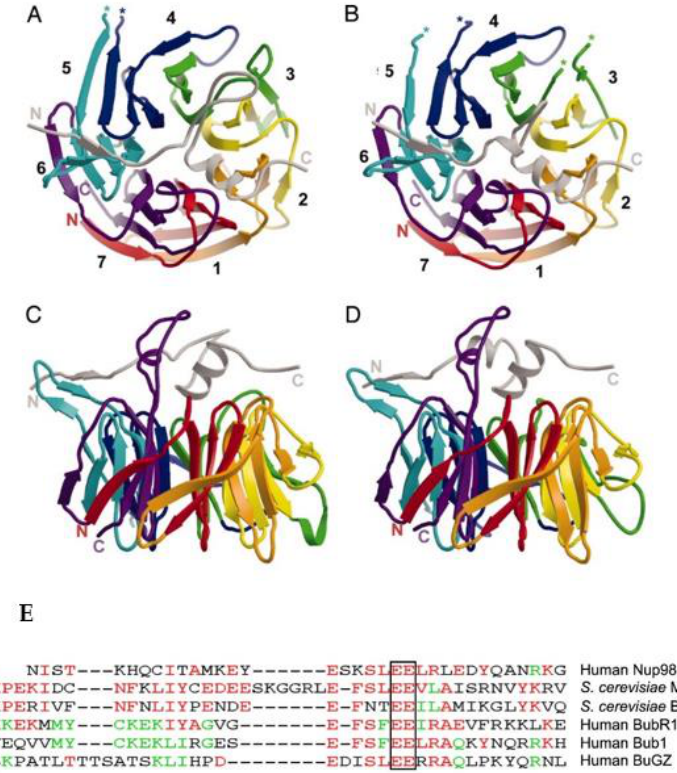
Figure 2. Top overview of Bub3 bound to GLEBS motif determined in yeast. ( A ) Top view of Bub3 bound to the GLEBS motif from Mad3 (BUBR1 in higher eukaryotes). The GLEBS peptide is colored in gray and lies along the top face of the propeller. N and C termini are labeled, and breaks in main- chain density are denoted with asterisks (*). ( B ) Top view of Bub3 bound to GLEBS motif from Bub1. Overall, the structures are quite similar, except that the Bub1 GLEBS motif has a shorter loop between helices α1 and α2. ( C , D ) Side views of Bub3 bound to Mad3/BUBR1 ( C ) and Bub1 ( D ) GLEBS motifs. The three- stranded β -sheet that includes the DA loop between blades 5 and 6 of Bub3 projects left- ward in these views. Numbers indicate blades. Reprinted with permission from [24]. Copyright 2021, National Academy of Sciences, U.S.A. ( E ) The conserved GLEBS motif in BUB1 and BUBR1 that binds BUB3; alignment of GLEBS motifs from hNUP98, scMad3, scBub1, hBUBR1, mBUB1, and hBuGZ; the completely conserved amino acids, EE, are boxed. Reprinted with permission from [37]. Copy- right 2022, Elsevier.